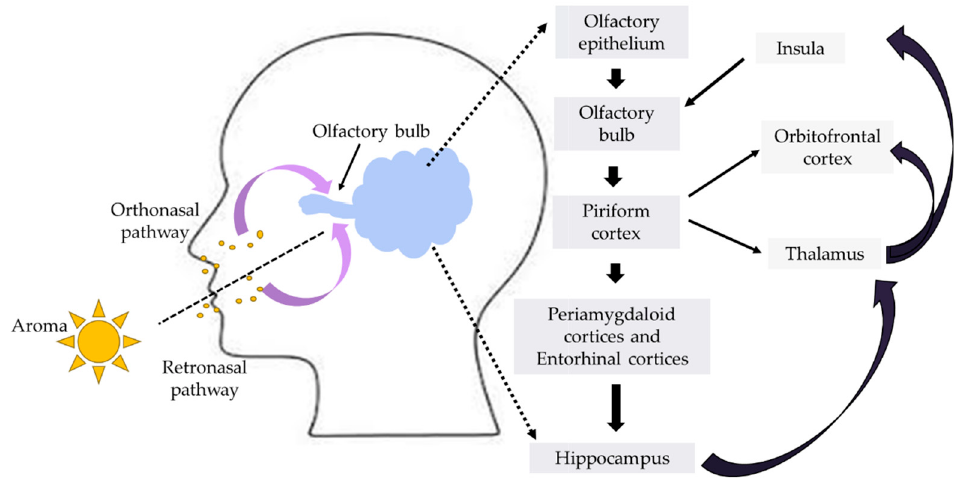
Figure 2. Schematic representation of the perception of aroma. Aroma enters via either the orthonasal or retronasal paths, reaching the olfactory centers of the brain through a signal cascade. Aroma transfers from olfactory epithelial neurons into the olfactory bulb. The olfactory efferent enters the piriform cortex (PC), entorhinal cortex, periamygdaloid cortex, and hippocampus. Olfactory neurons from the PC enter the orbitofrontal cortex (OFC) and thalamus. Thalamus and OFC neurons are connected to the insular cortex [52].